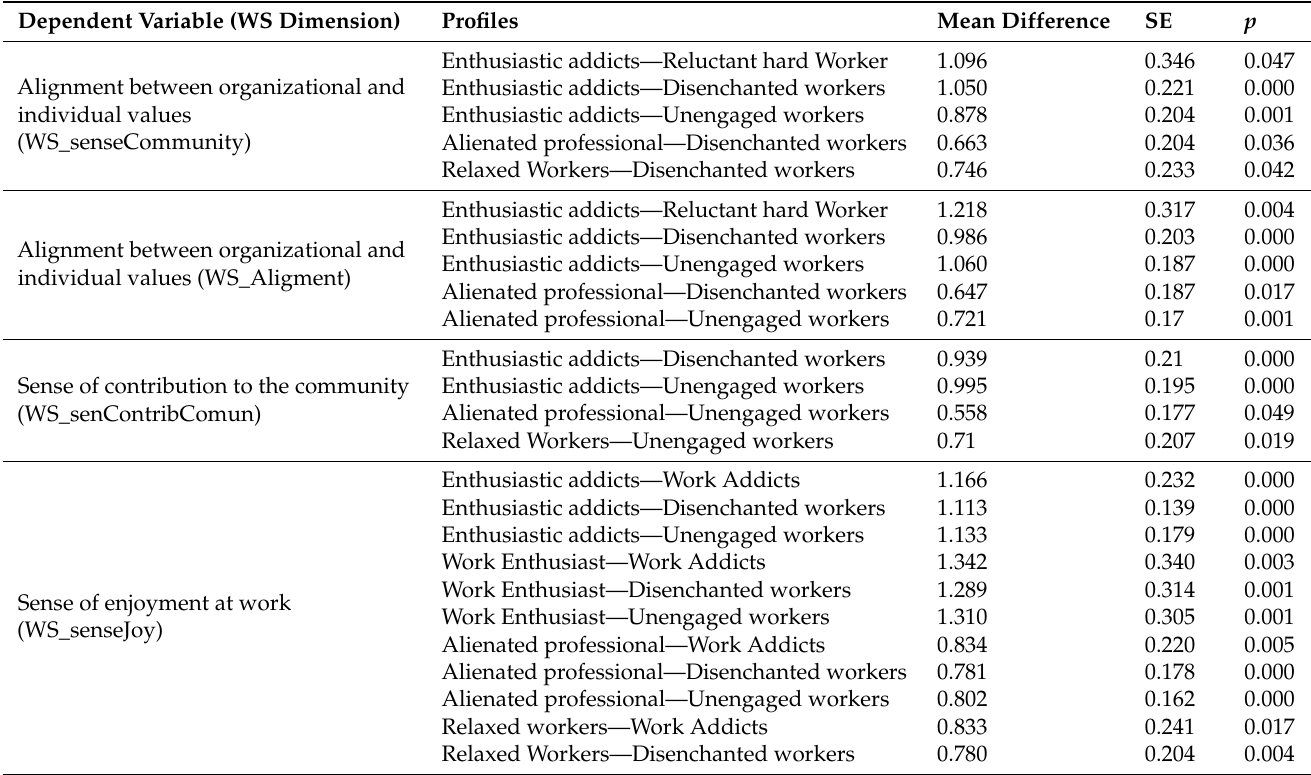
Table 7. Workplace Spirituality means difference of each profile and multiple comparison tests between profiles. Dependent Variable (WS Dimension) Profiles Mean